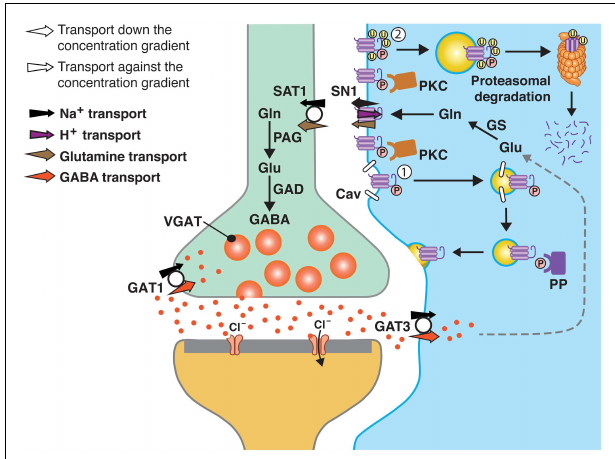
FIGURE 1 |A model of SN1 membrane trafficking based on consolidated data on the regulation of SN1 activity by protein kinase C (PKC) .The cartoon depicts a GABAergic synapse in adult rat brain where GABA is released exocytotically and acts upon specific post-synaptic receptors.The signal is terminated by removal of GABA from the synaptic cleft by transport of GABA back into the nerve terminal by the plasma membrane GABA transporter (GAT) 1. A substantial amount of GABA in the synaptic cleft is also transported into perisynaptic astroglial processes by GAT3 (and GAT1) and converted to glutamate, and then to glutamine catalyzed by glutamine synthetase (GS). Glutamine may then be released from the astroglial cells by the electroneutral and bidirectional system N transporter 1, SN1, and may subsequently be accumulated inside GABAergic neurons by the system A transporter SAT1. Here, glutamine is metabolized to yield glutamate and then GABA by the action of phosphate-activated glutaminase (PAG) and glutamic acid decarboxylase (GAD), respectively. Finally, GABA is translocated into synaptic vesicles by the vesicular GABA transporter (VGAT), wherefrom it is ready to be exocytotically released. Astroglial PKC may be activated upon stimulation of specific receptors on the astroglial membranes or e.g., by excessive amounts of Mn 2 + . PKC α and PKC γ (and PKC δ ) can phosphorylate SN1 on a serine at the 52 position.This results in caveolin (Cav)-dependent internalization of SN1 from the plasma membrane (1).The internalized SN1 may be relocated to the plasma membrane upon dephosphorylation by protein phosphatases (PP). PKC-mediated phosphorylation of SN1 also increases ubiquitination of SN1 (2).This may also internalize the protein into intracellular compartments and target it to the proteasomal degradation pathway. Similar regulation of SN1 activity also takes place at glutamatergic synapses.The same mechanisms are likely to be involved in the regulation of SN1 in hepatocytes, renal tubule cells, and the pancreatic